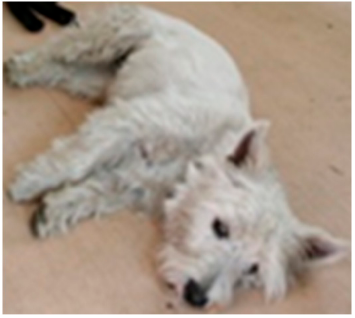
Figure 3. Dog region.